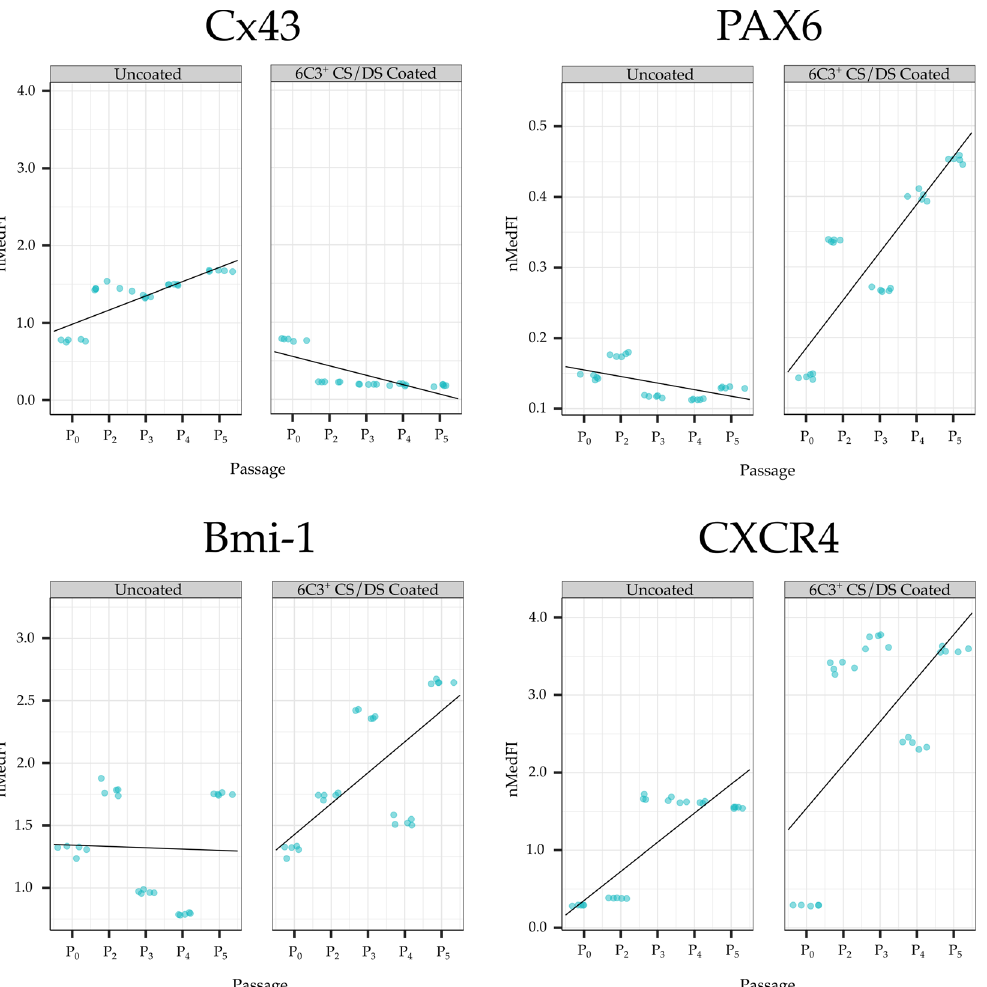
Figure 3. Linear regression showing the relationship between nMedFI and passage number in each coating condition for Cx43, PAX6 , Bmi-1 and CXCR4. Each point represents a repeated instrument measure of nMedFI at each passage for each PSSC marker and coating.